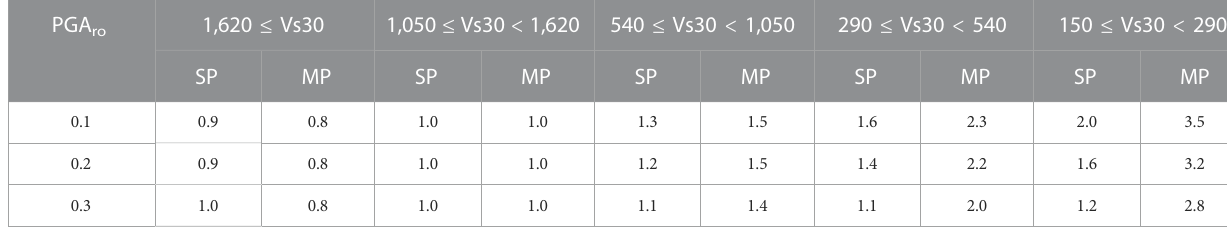
The results of verifying the transfer function based on the proposed method for 45 events in 21 station records are shown in Figure 13. The seismic intensity was calculated by Eqs 4, 5, and the fi rst decimal place